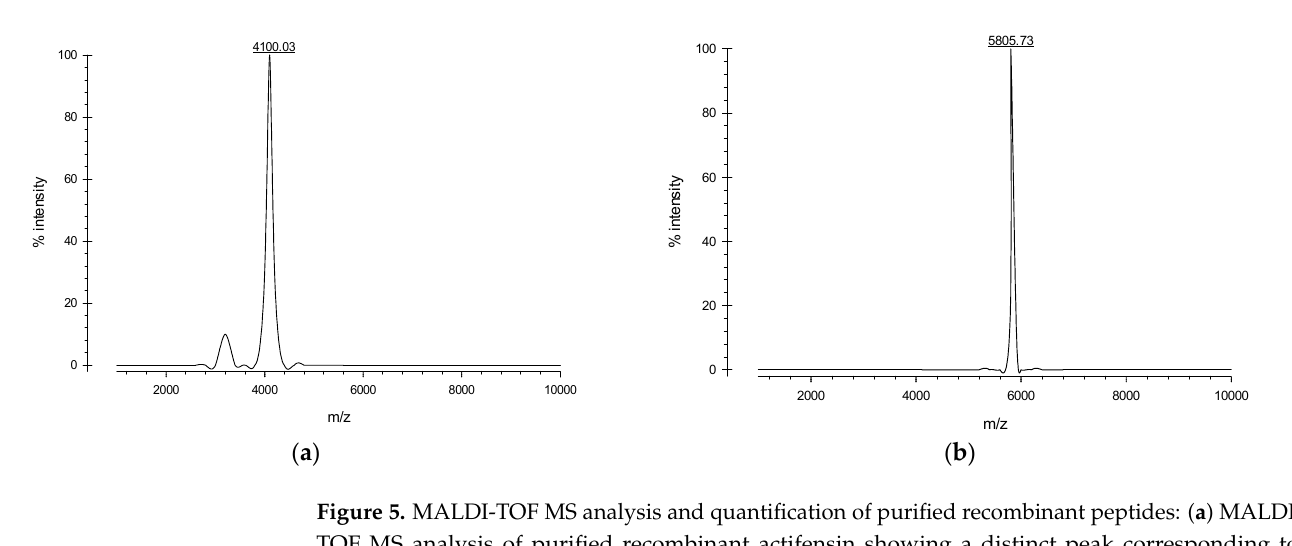
Figure 5. MALDI-TOF MS analysis and quantification of purified recombinant peptides: ( a ) MALDI-TOF MS analysis of purified recombinant actifensin showing a distinct peak corresponding to 4100.03 Da; ( b ) MALDI-TOF MS analysis of purified recombinant defensin-d2 showing a distinct peak corresponding to 5805.73 Da. Table 2. Minimum inhibitory/bactericidal/fungicidal concentrations of recombinant actifensin and defensin-d2.